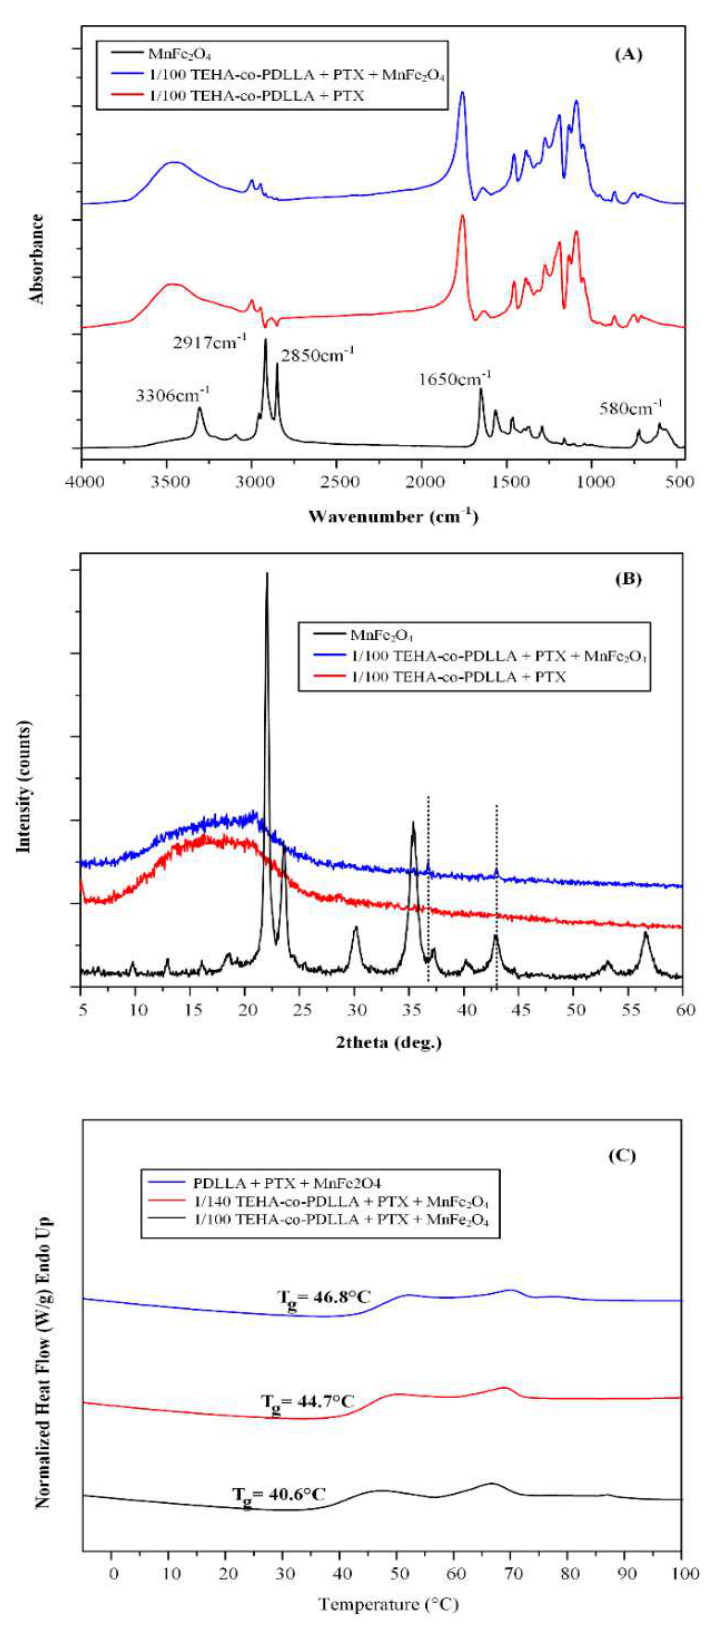
Figure 7. FTIR spectra ( A ), XRD diffractograms ( B ), and DSC thermograms ( C ) of magnetic core–shell drug-loaded polymeric nanoparticles.